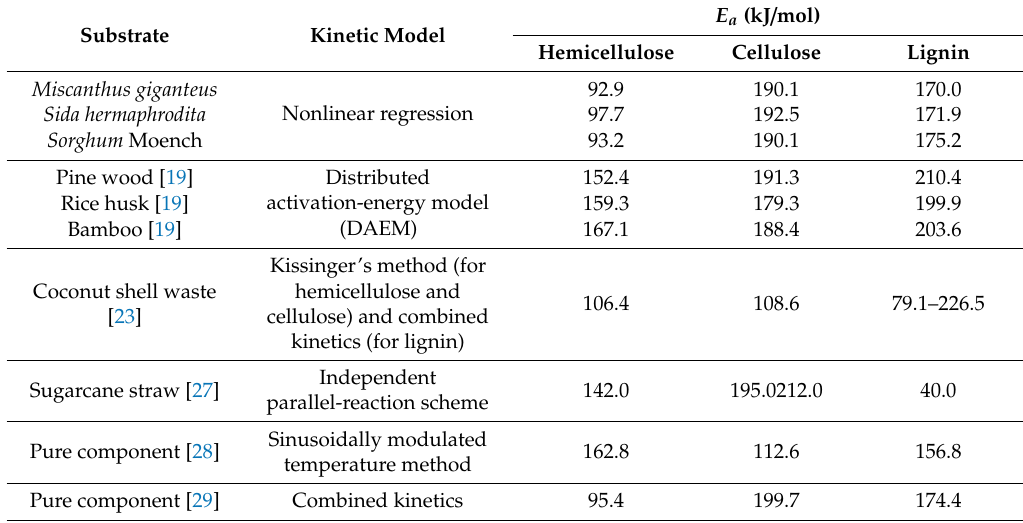
Table 4. Activation energies for pyrolysis of hemicellulose, cellulose, and